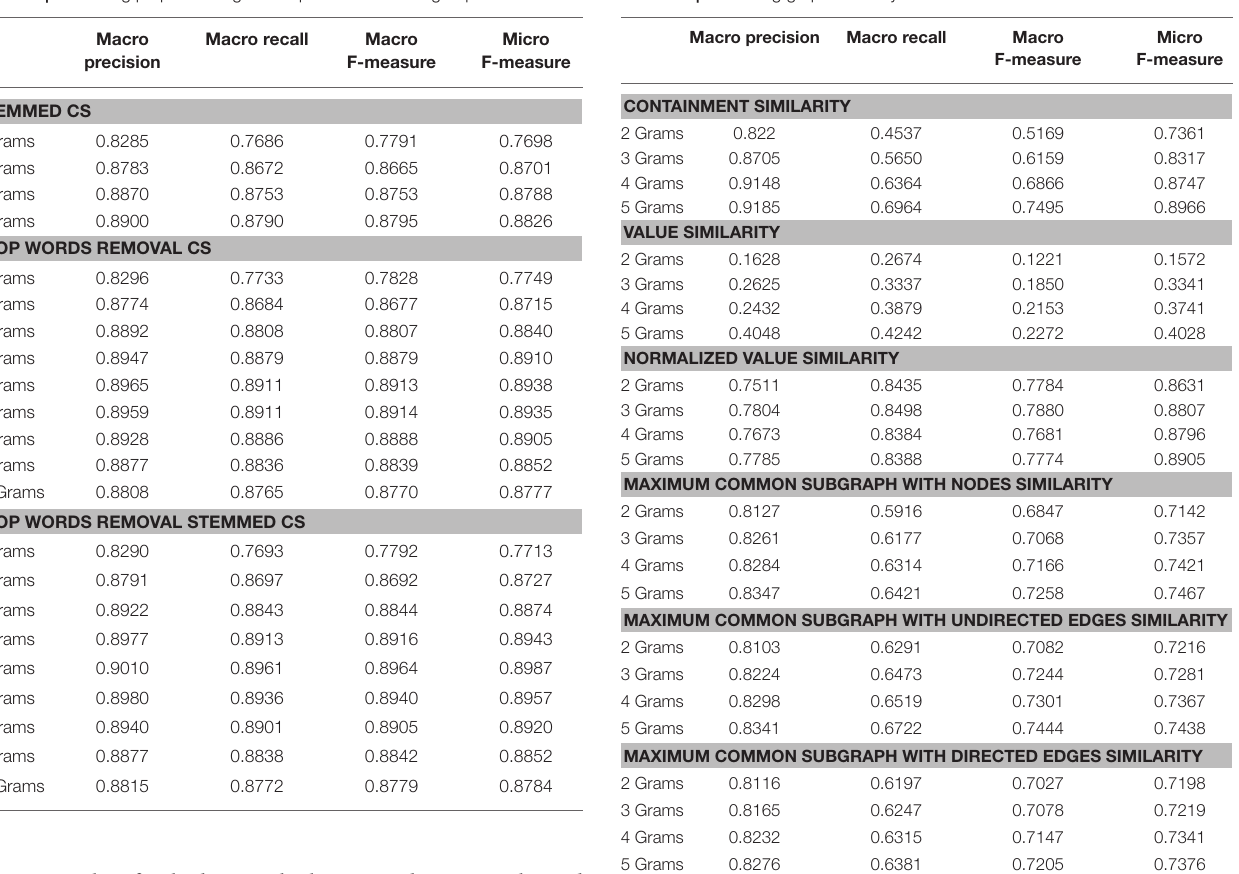
TABLE 2 | Evaluating preprocessing techniques with 20Newsgroup. TABLE 3 | Evaluating graph similarity metrics with